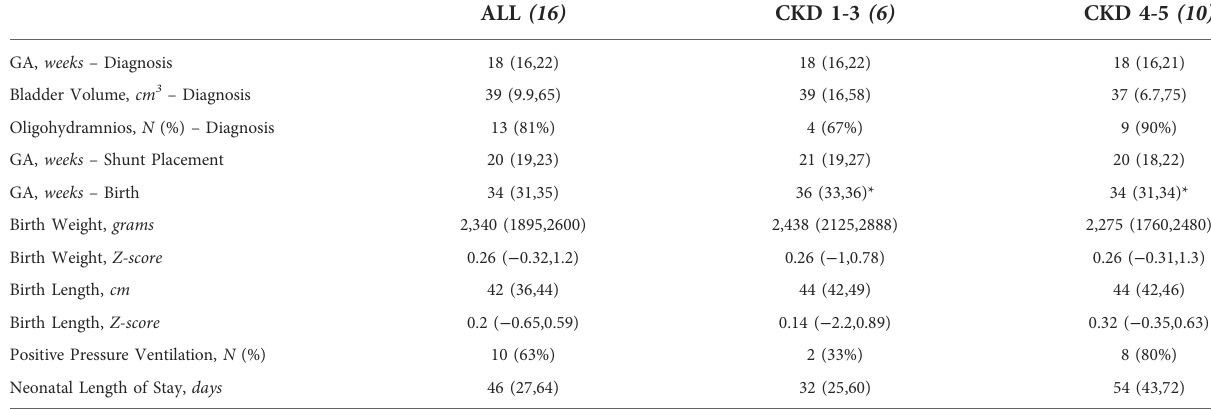
TABLE 2 Perinatal